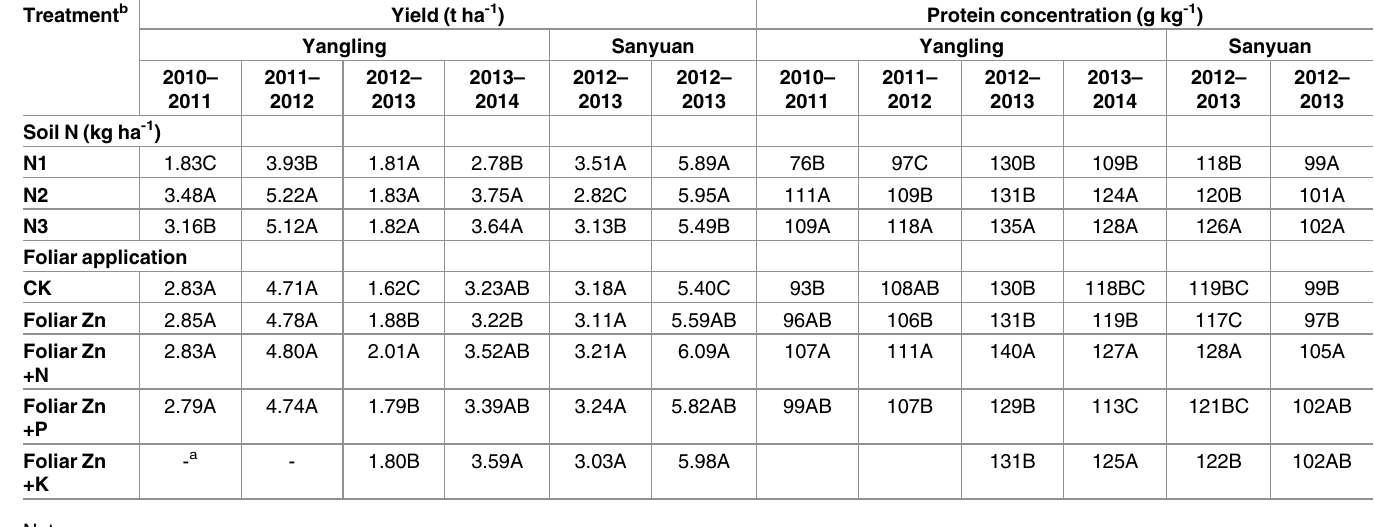
Table 4. Grain yield and protein concentration of winter wheat as influenced by soil N fertilizer rate and foliar fertilizerapplications under field con- ditions at Yangling during 2010–2014and Sanyuan during 2012–2014. Treatment